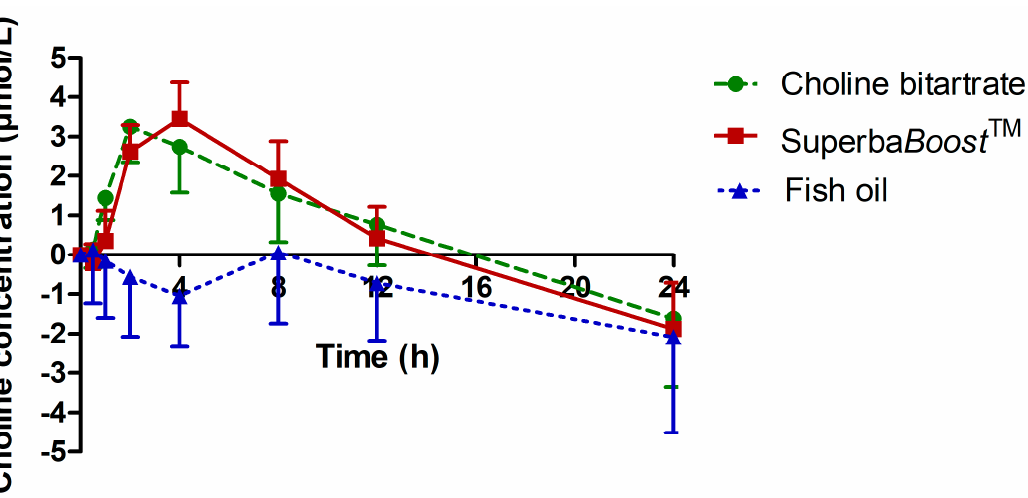
Figure 2. Plasma concentration–time curve of choline. Values are baseline-corrected and dose-adjusted. Choline bitartrate: n = 12; Superba Boost TM : n = 12; fish oil: n = 6.